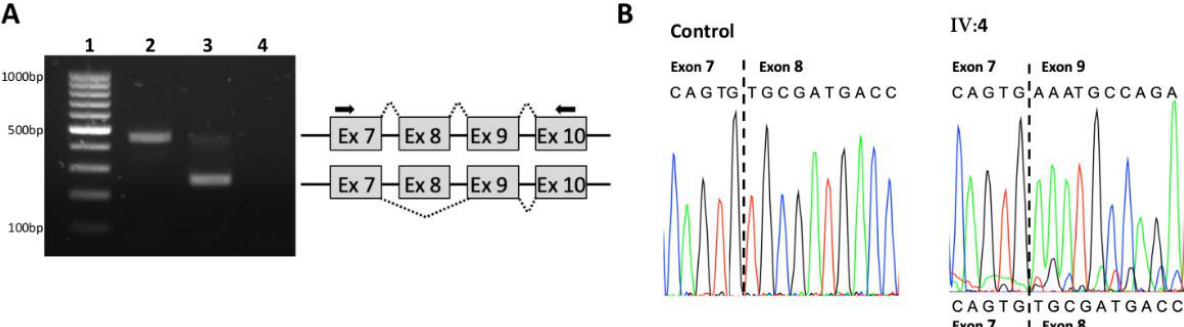
Figure 4. ( A ) RNA analysis of the c.991-60_1095del variant. ( A ) Agarose gel electrophoresis of the RT-PCR products from a control (lane 2) and the proband IV:4 (line 3). Lane 1: molecular weight markers, lane 4: control PCR reaction without template. A schematic representation of the spliced products is included. The position of the primers used for the amplification is shown by arrows. ( B ) Sanger sequencing electropherograms of the RT-PCR products for the control and the patient.